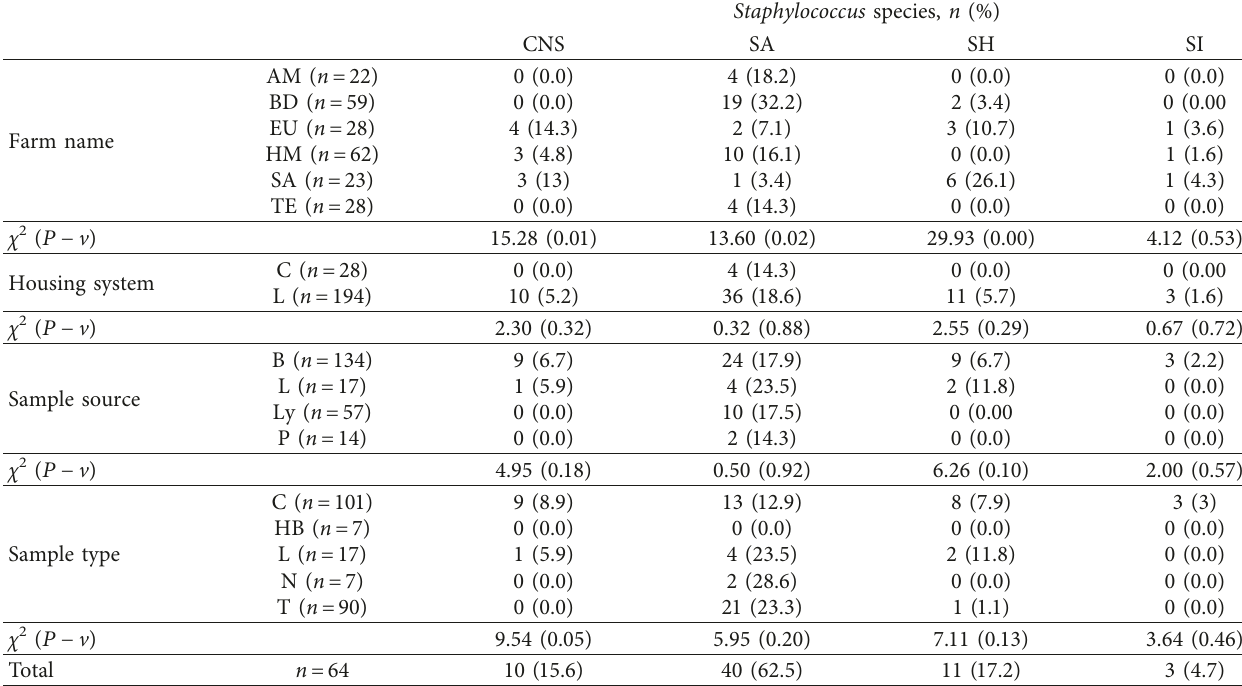
Table 2: The proportional distribution of Staphylococcus species isolated from different farms, housing systems, sample sources, and different sample